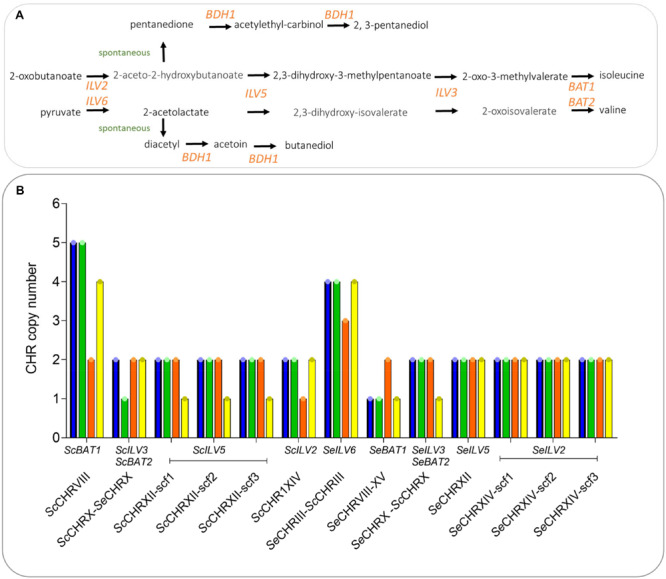
Vicinal diketones formation in S. pastorianus. (A) Schematic illustration of the diacetyl, pentanedione and branched chain amino acid biosynthesis pathways. (B) Valine, isoleucine, pentanedione and diacetyl biosynthetic pathways and chromosome copy number of the genes involved in the metabolic routes in strains CBS 1384 (blue bar), IMI373 (ScCHRX-SeCHRX– 1 SeCHRIX–1) (green bar) that was targeted for loss of ScCHRX, IMI375 (ScCHRII–1
ScCHRV–1
ScCHRVIII–3
ScCHRXIII–1 ScCHRXIV–1 SeCHRI–1
SeCHRIII-ScCHRIII–1
SeCHRVII-ScCHRVII–1
SeCHRVIII-XV+1) (orange bar) that was targeted for loss of ScCHRXIV and IMI381 (ScCHRIV+1
ScCHRVIII–1
ScCHRIX+1
ScCHRXI–1
ScCHRXII–1
SeCHRX-SeCHRX–1
SeCHRII-IV–1
SeCHRXI+1) (yellow bar) that was targeted for the loss of SeCHRX. The chromosome copy number was predicted using Magnolya (Nijkamp et al., 2012).